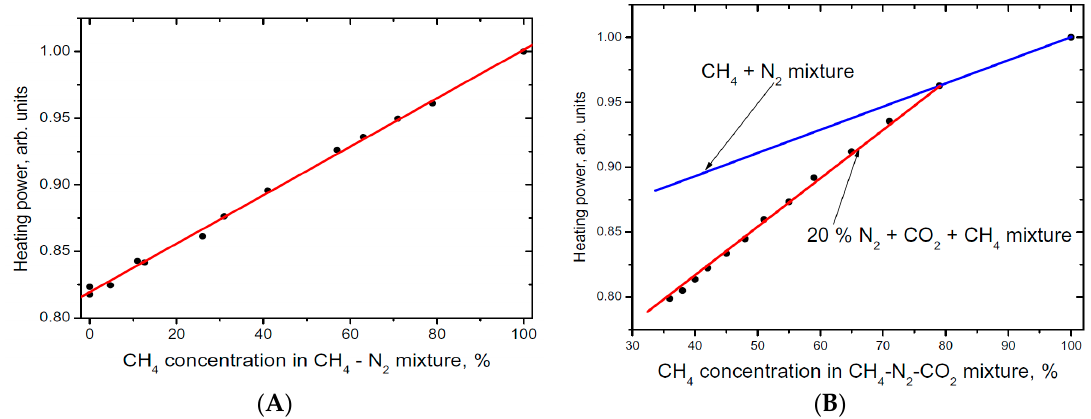
Figure 4. ( A ) Heating power (sensor signal) as a function of methane concentration in methane—nitrogen gas mixture. Temperature of the microheater is stabilized at 150 °C over room temperature. ( B ) Heating power as a function of CH 4 concentration in CH 4 –N 2 –CO 2 mixture. N 2 concentration was fixed at 20%, measurements were performed at different concentrations of CO 2 and CH 4